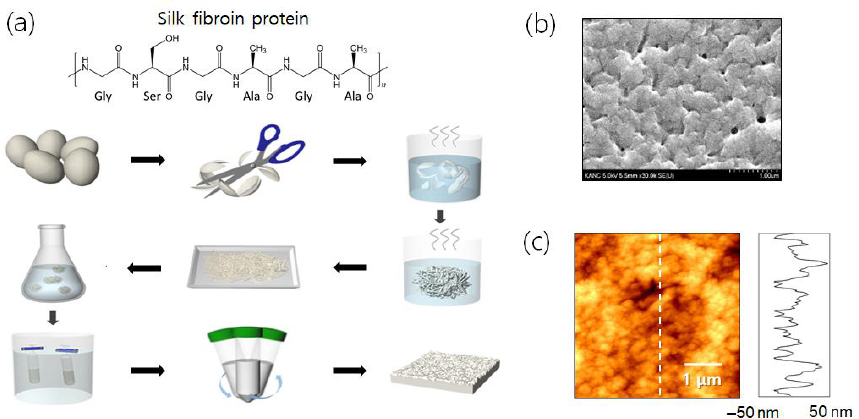
Figure 1. A highly porous free-standing silk substrate for SERS sensor application. ( a ) Procedures for fabricating a porous silk substrate. ( b ) FE-SEM image of the fabricated silk sample with a high porosity. ( c ) AFM image of the silk substrate and its surface profile.